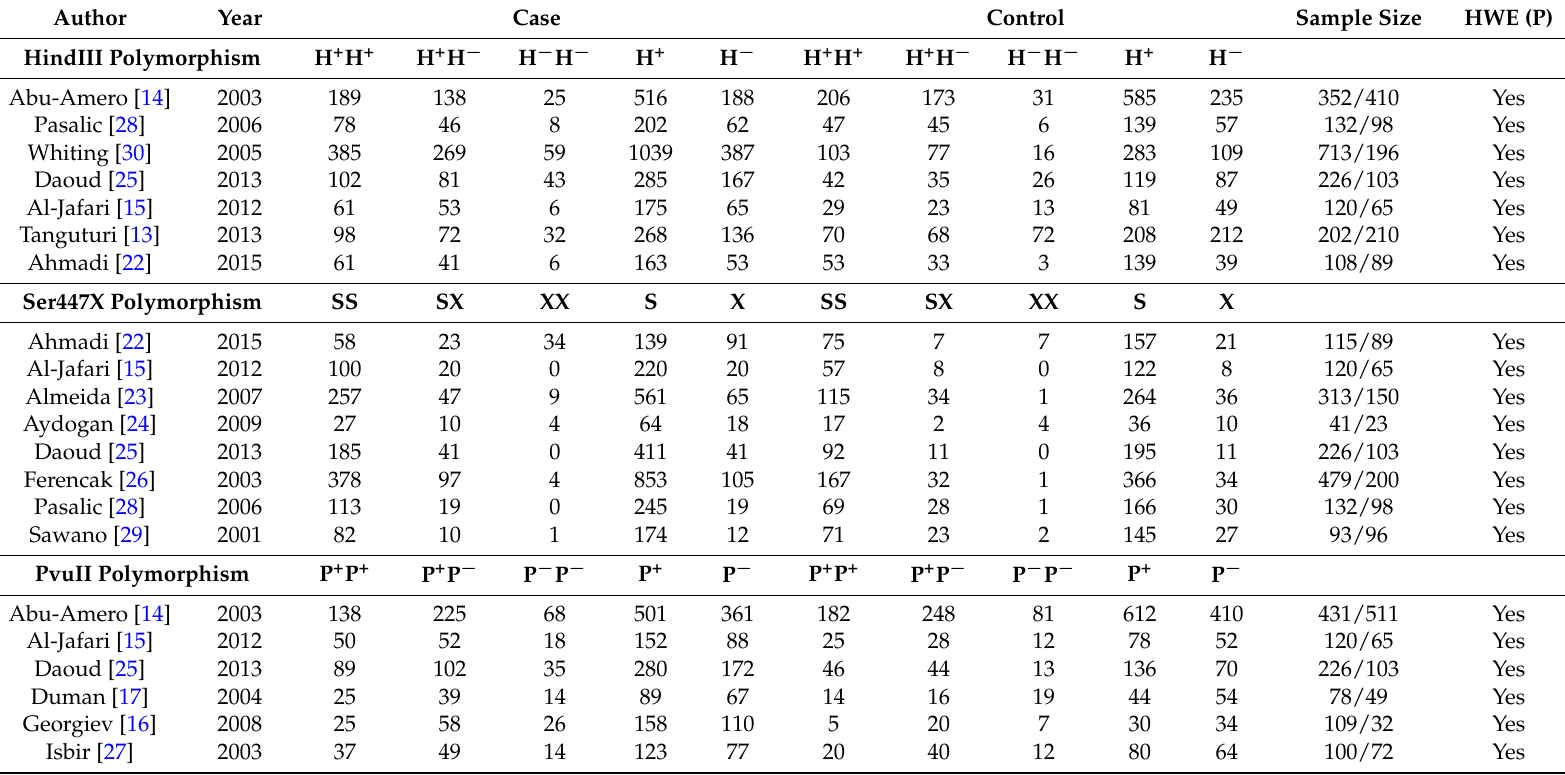
Table 2. Genotypes and allele frequencies of Lipoprotein Lipase (LPL) genes in patients and